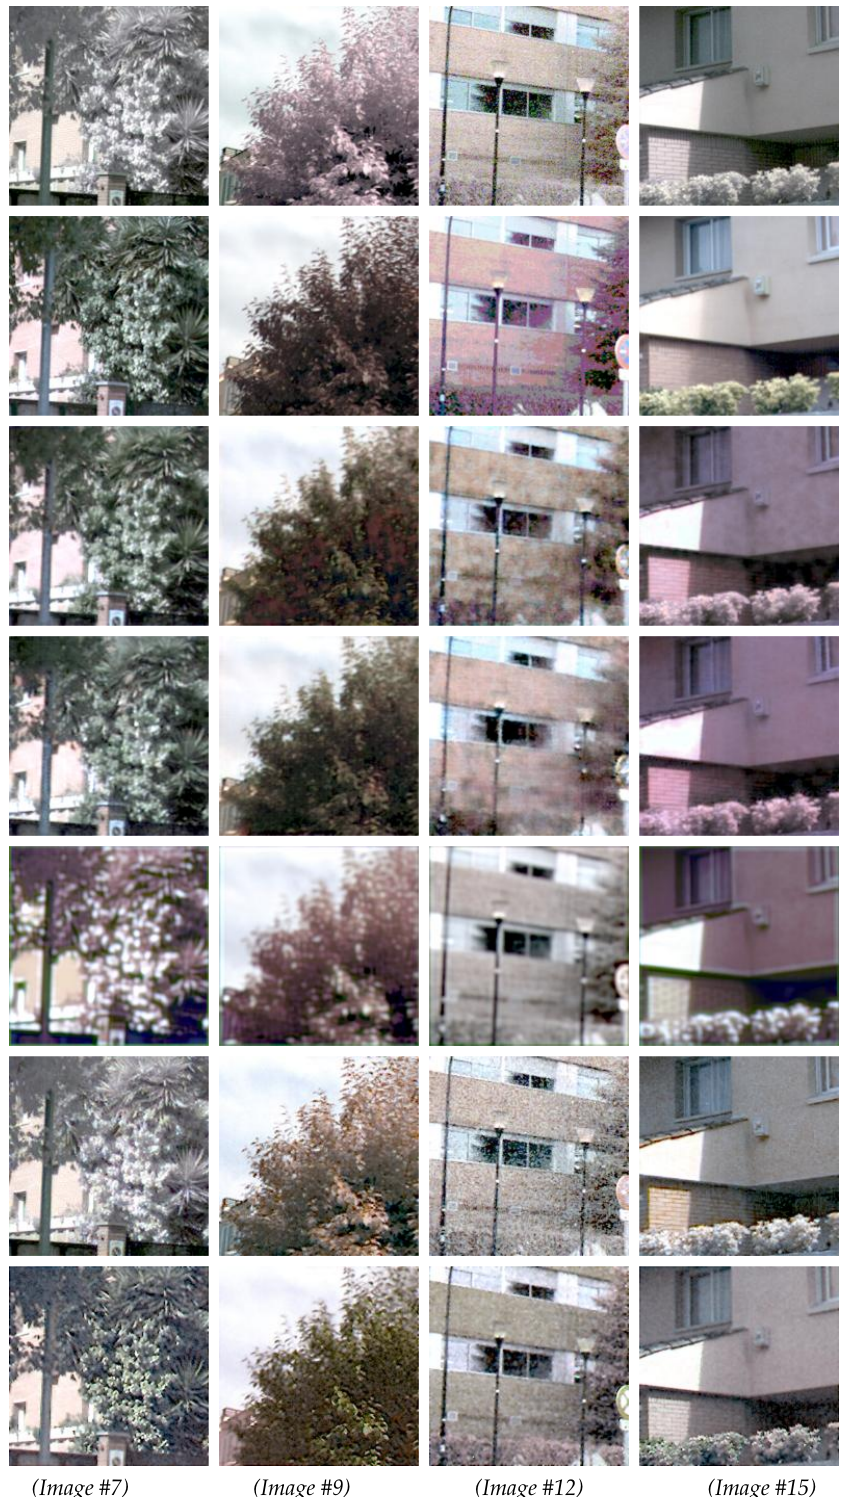
Figure 6. Four samples from the average and worst results (see Table 2). ( 1st row ) X images (RGB + N). ( 2nd row ) Y (ground truth). ( 3rd row ) Results from CDNet. ( 4th row ) Results from ENDENet. ( 5th row ) Results obtained with SRCNN ([30]). ( 6th row ) Results obtained with ref. [21]. ( 7th row ) Results obtained with ref. [20]. The image numbers correspond to the values presented in Table